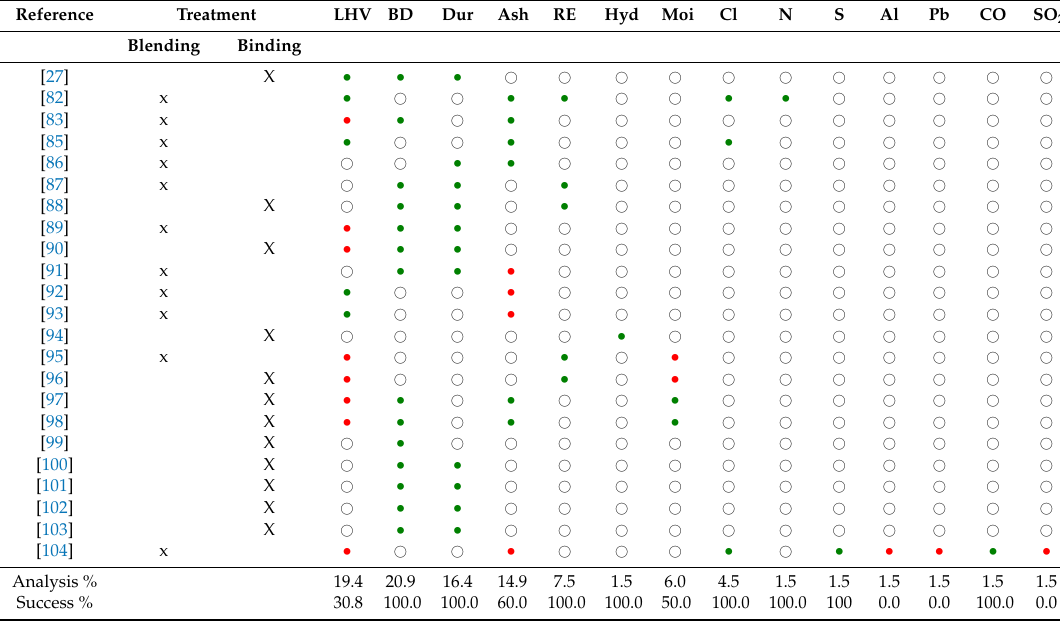
Table 3. Overall summary of the e ff ect of blending or binders on pellet quality. Green cue balls indicate a positive e ff ect of the blending / binder on the variable, red cue balls indicate a negative e ff ect on the variable, and white cue balls represent that the variable was not investigated in the study or that no e ff ect was found by the authors. LHV: lower heating value; BD: bulk density; Dur: durability; Ash: ash content; RE: energy required for pelletization; Hyd: hydrophobicity; Moi: moisture. “Analysis %” represents the ratio between the number of papers that analyzed variable “x” and the total number of analyses conducted on all variables in every investigated paper. “Success %” represents the ratio between the number of papers that showed a good e ff ect of the blend / binder on variable “x” and the total number of papers that analyzed variable